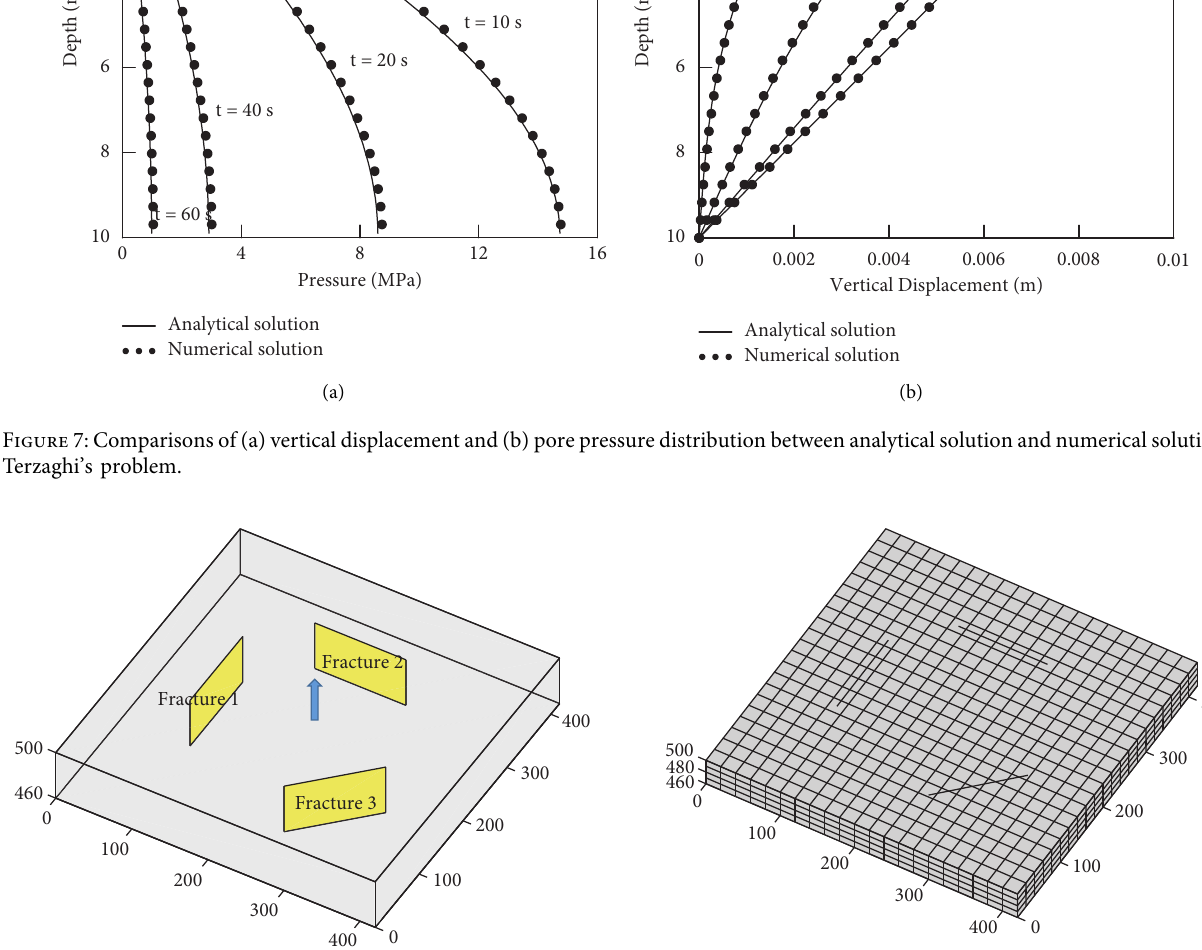
Figure 9: Mesh in the